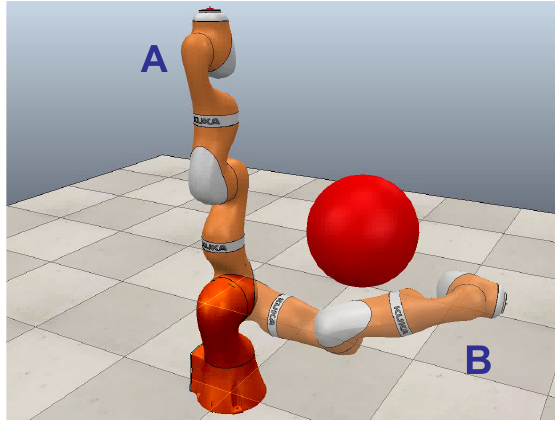
Figure 1. Robot manipulator collision-free path planning